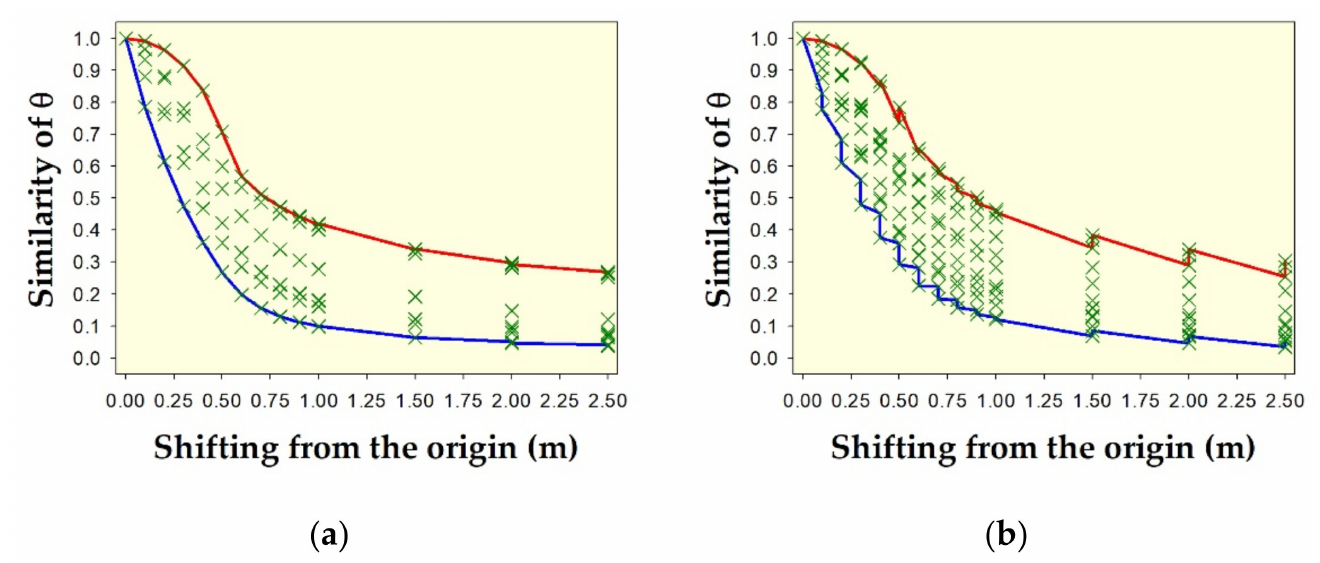
Figure 11. PDF similarity of angle from the centroid of origin to each point ( θ ) of two hypothetical shapes: ( a ) circle with diameter of about 1.0567 m, and ( b ) square with dimensions of 1.0567 × 1.0567 m 2 , due to shifting from the origin in all directions. Green crosses indicate similarity of θ from all nine metrics. Red lines on the upper edge of the envelopes indicate the similarity of θ using the Fidelity metric. Blue lines on the lower edge of the envelopes indicate the similarity of θ using the Soergel–Ruzicka–Tanimoto metric.